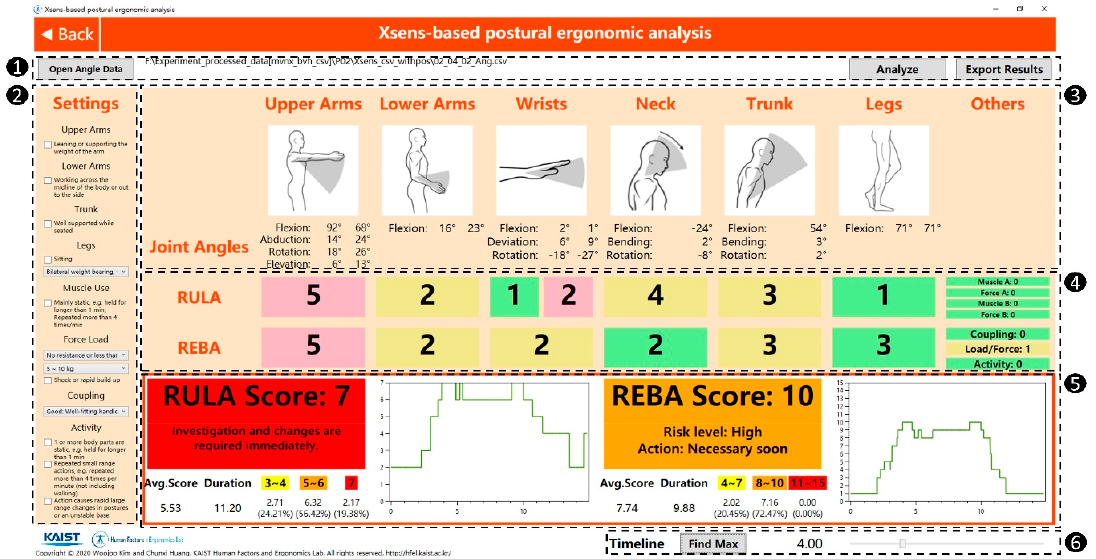
Figure 4. The GUI of the automated RULA/REBA assessment tool in the developed system. Numbers in black circles indicate the number of each section.